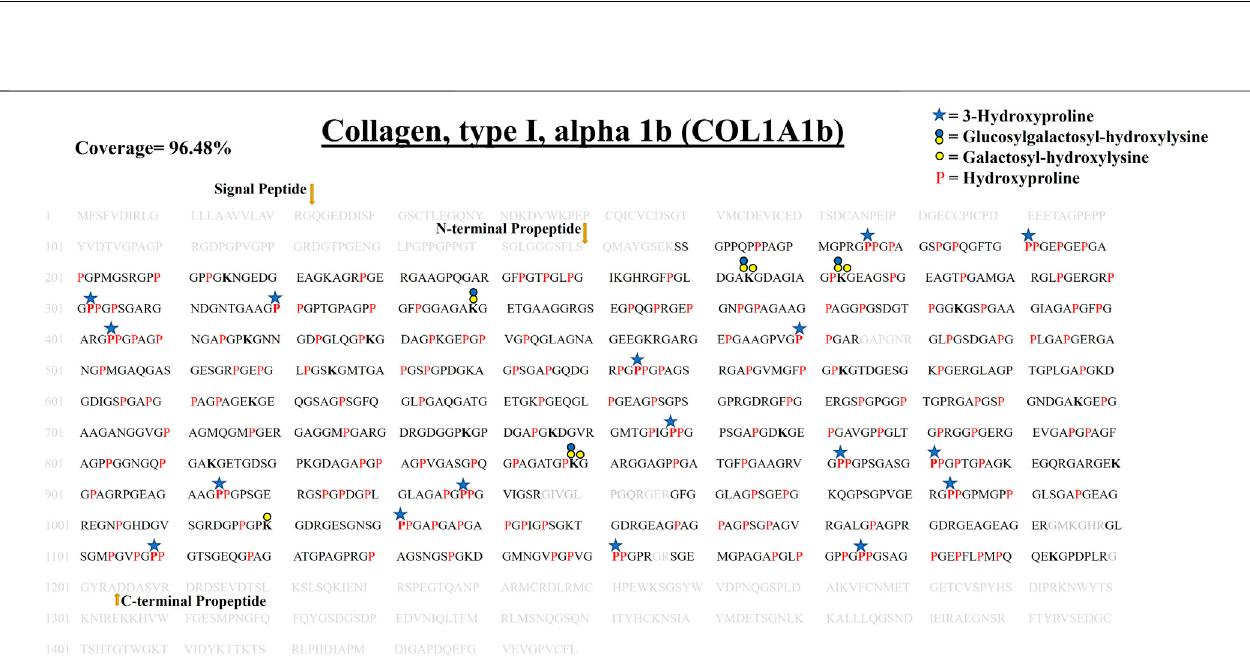
FIGURE 5 | Comprehensive PTM map of COL1A1b of WT zebra fi sh heart ECM, presenting proline/lysine hydroxylation sites and lysine O-glycosylation sites. The representation ofPTMstheites issimilar totheCOL1A1aPTM map asshown in topright corner.Peptides identi fi ed inproteomics analysisareshown inblackcolorand unidenti fi ed peptides are shown in grey color. A total of 96.48% sequence coverage of COL1A1a is detected (considering the matured form of COL1A1b). The signal peptide is 22 amino acids (1 – 22) long. Sequence alignment matching and previous analysis by Gistelink et al. with human COL1A1 revealed the propeptide cleavage sites. Dark yellowarrows show N terminal (23 – 150) and C-Term (1,204 – 1,447) propeptidecleavage sites. Red bold “ P ” with ablue star represents 3-HyP and red “ P ” represents 4-HyP. Hydroxylysine is represented with bold “ K ” and yellow and blue circle represents the lysine O-glycosylation. A summary of these site-speci fi c PTMsofCOL1A1bispresented in Table1 ,and allthePSMsforO-glycosylated lysineand3-hydroxyprolinesitesareprovidedinSupplementaryFigures.S2.22 – S2.52.